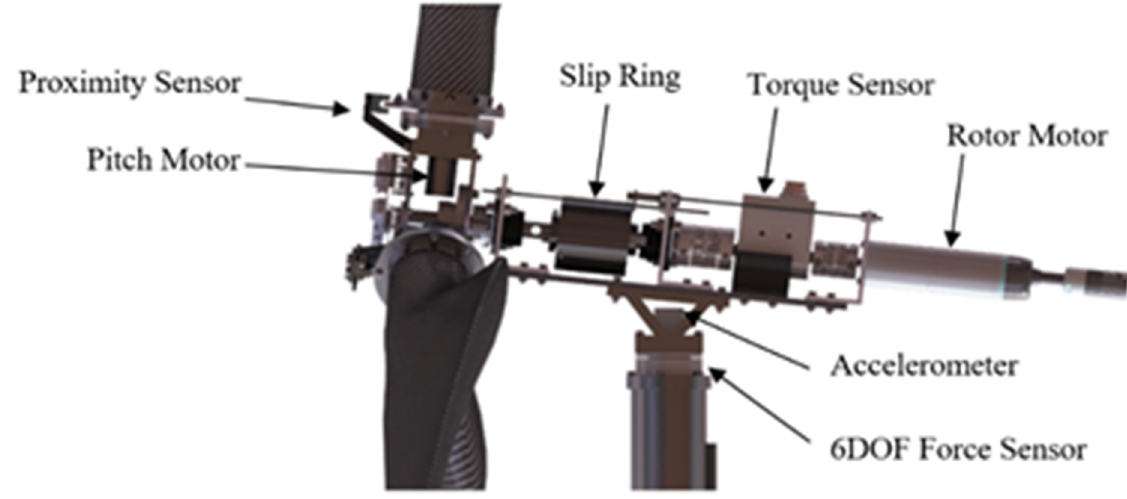
Figure 1. Instrumentation